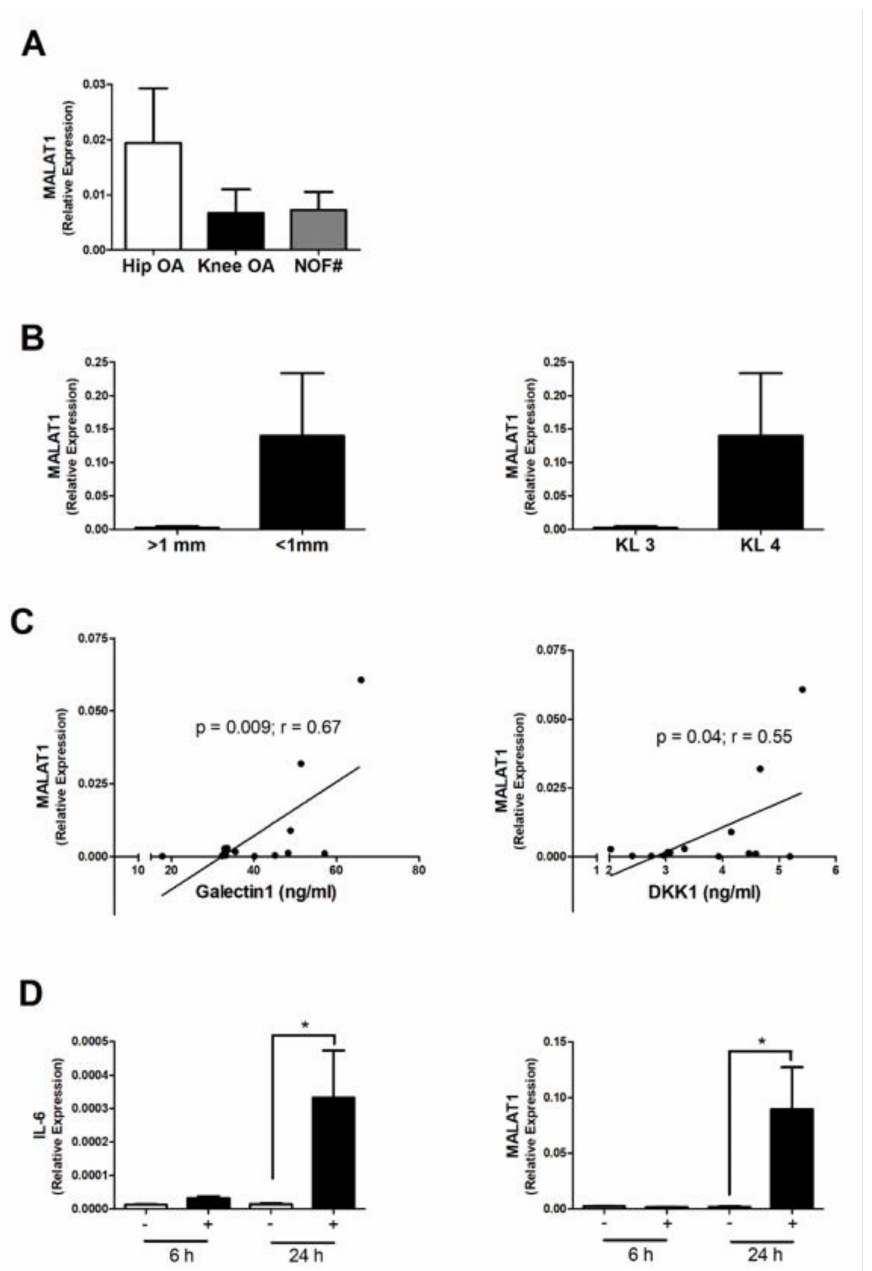
Figure 1. Expression of MALAT1 in subchondral bone and OA osteoblasts. ( A ) Relative expression of MALAT1 in the subchondral bone tissue of end-stage hip OA patients ( n = 9) compared to end-stage knee OA patients ( n = 8) and non-OA neck of femur fracture (NOF#) patients ( n = 6). MALAT1 expression was determined by qPCR and normalised to 18S. Bars represent mean expression ± SEM. ( B ) Relative expression of MALAT1 in the subchondral bone tissue between OA patients with more severe radiographic signs of OA ( n = 13) with joint space < 1 mm and KL grade 4, compared to those with less severe joint damage ( n = 4) with joint space > 1 mm and KL grade 3. ( C ) Correlation between subchondral bone expression of MALAT1 and the serum concentration of Galectin 1 (ng/mL) and DKK1 (ng/mL) in OA patients ( n = 17). ( D ) Effect of IL-1 β stimulation (1 ng/mL) upon the expression of IL-6 and MALAT1 in primary OA osteoblasts at 6 h and 24 h. * = p < 0.05, compared to non-stimulated